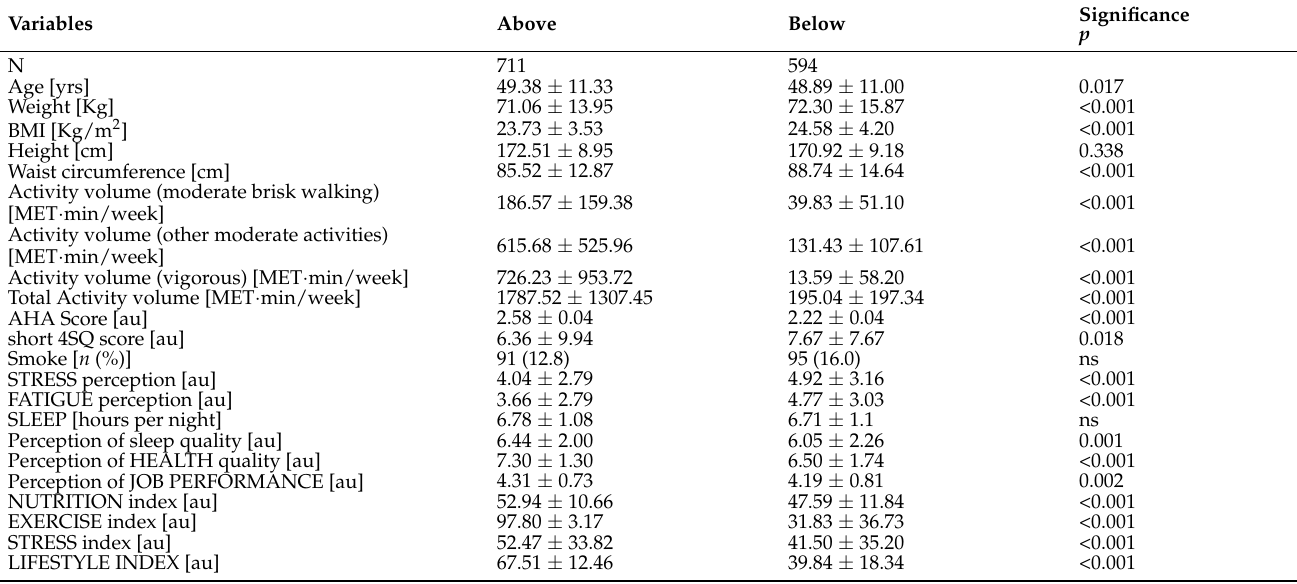
Table 2 reports the data regarding employees who reached the physical activity goals (Above 600 (MET · minutes/week) considering Total Weekly physical activity volume), and those who did not. More active employees presented with a lower BMI and waist circumference, reduced scores for somatic symptoms, stress and fatigue perception, and a better AHA Diet Score. The global lifestyle index was higher (healthier) in this population, particularly its stress component (see Figure 1). It is important to consider that the indexes, including the Stress Index, range from 0 to 100, and were built so that higher scores are healthier. More active employees report a higher perception of sleep quality, health quality and of job performance. Table 2. Anthropometric and lifestyle data observed in workers whose weekly physical activity is above or below the current physical activity goals. Above Below